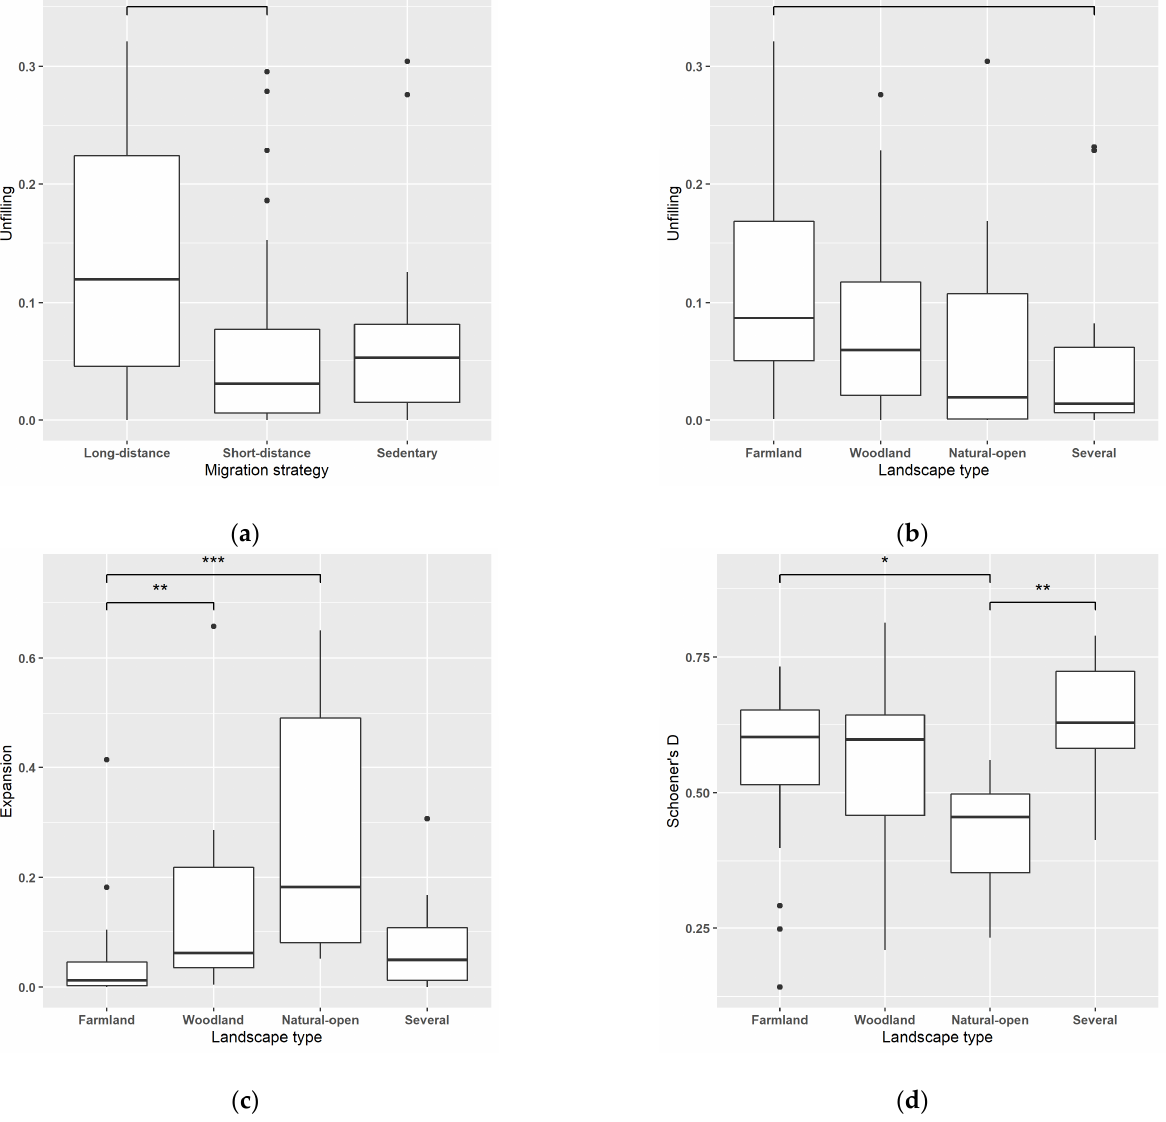
Figure 7. Box plots and significance level of Dunn’s test for pairwise comparisons for categorical traits for which Kruskal–Wallis test detected significant differences. ( a ) Migration strategy and unfilling; number of species per group: long-distance = 20, short-distance = 29, sedentary = 22; Landscape type and ( b ) unfilling, ( c ) expansion, ( d ) Schoener’s D (niche overlap); number of species per group: farmland = 28, woodland = 16, natural-open= 8; several = 19. Whiskers are 1.5 × IQR. Black dots represent outliers. Horizontal bars in the upper area indicate which group comparisons showed statistically significant differences. Asterisks represent the significance level: ≤0.001: ***, ≤0.01: **, ≤0.05: *. See Table S2 for further details on species traits.